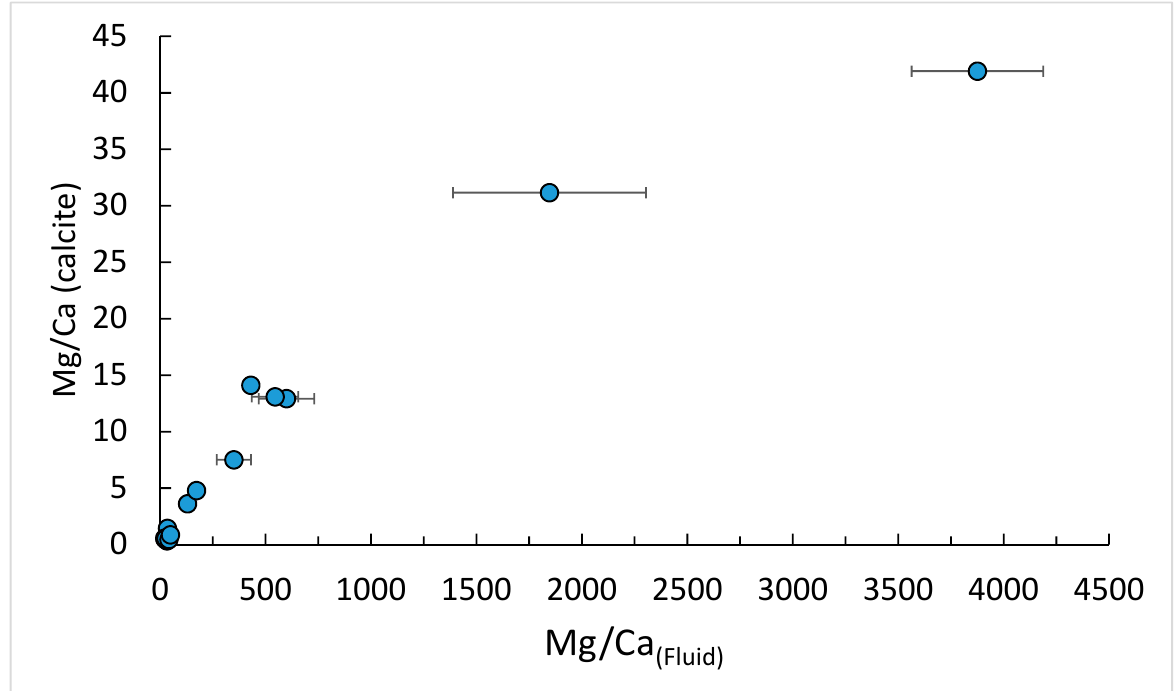
Figure 5. Mg/Ca concentration as a ratio in precipitated calcite plotted as a function of averaged aqueous Mg/Ca concen- tration as a ratio (in mmol/mol). The Mg/Ca (Fluid) analytical uncertainty was determined in terms of the standard error.